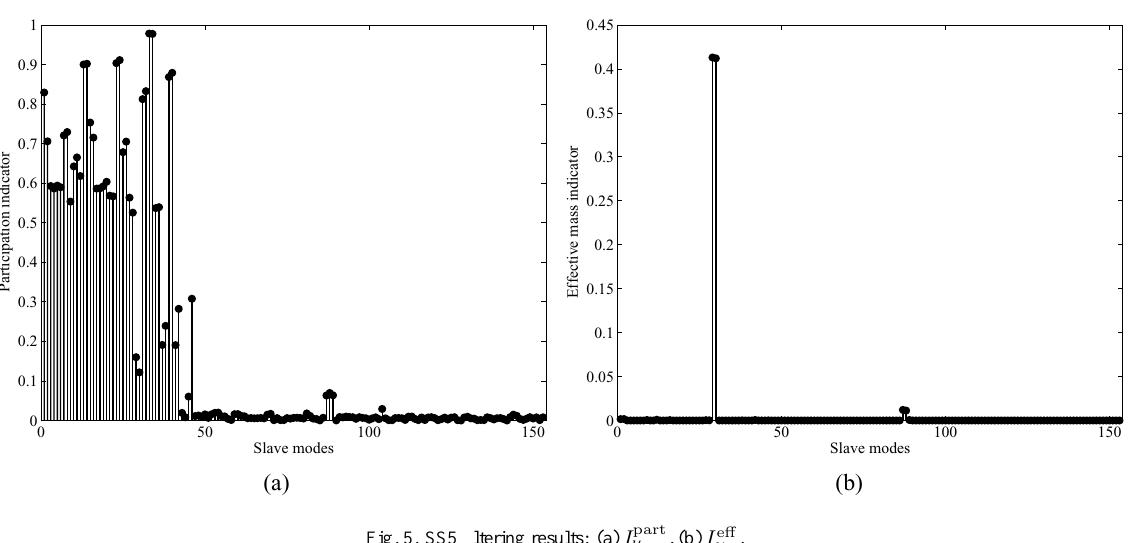
Fig. 5. SS5 filtering results: (a) I part ν , (b) I eff ν